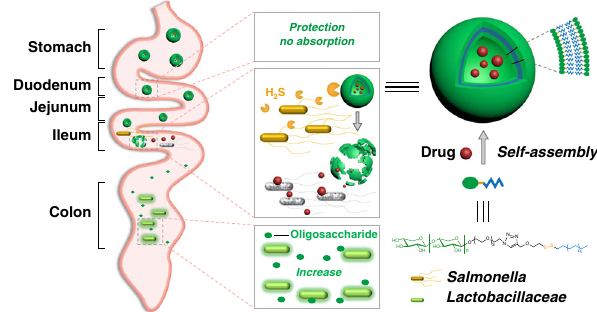
Fig. 5 A proposed model for how AM vesicles resolve salmonellosis ef fi ciently. The envisioned paradigm of AM vesicles to protect cipro fl oxacin (CIP) from absorption, eliminate Salmonella bacteria locally and promote Lactobacillaceae